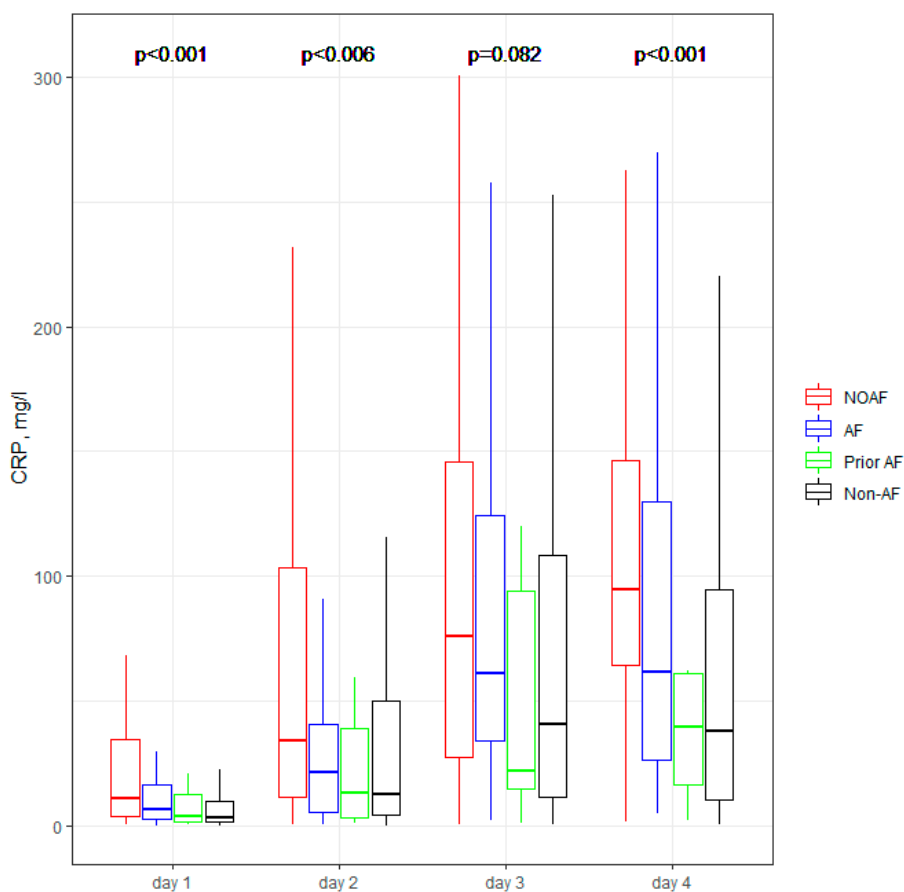
Figure 2. CRP concentration within the first four days of hospitalization. The center represents the median value. The upper and lower quartiles values are displayed with whiskers. p -values on the figure represent the group changes (the Kruskal–Wallis test). The time changes were calculated by the Friedman test and paired samples Wilcoxon test with Bonferroni adjusted ( p < 0.001). CRP—C-reactive protein; NOAF—group of patients with any newly diagnosed AF that appeared during AMI hospitalization; AF—group of patients with a previously documented diagnosis of AF who additionally had AF during AMI hospitalization; Prior AF—group of patients with a previously documented diagnosis of AF who had not developed AF during AMI hospitalization; Non-AF—group of patients with no evidence of AF during AMI hospitalization and without the prior AF diagnosis.